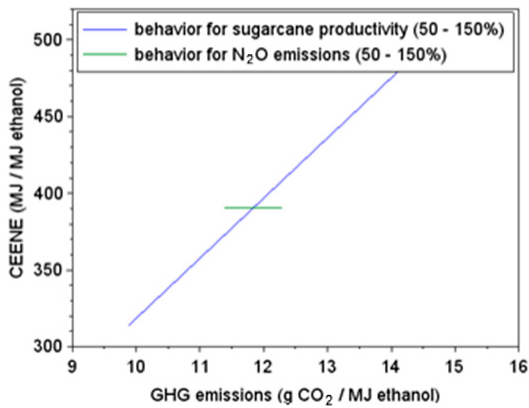
Figure 7. Relationship of CEENE and GHG emissions with ( a ) the variation of sugarcane productivity; ( b ) the N 2 O variation emitted in the soil.